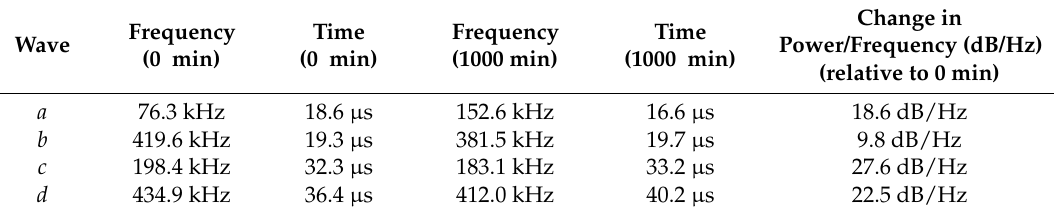
Table 3. Oval specimen (Far): Wave